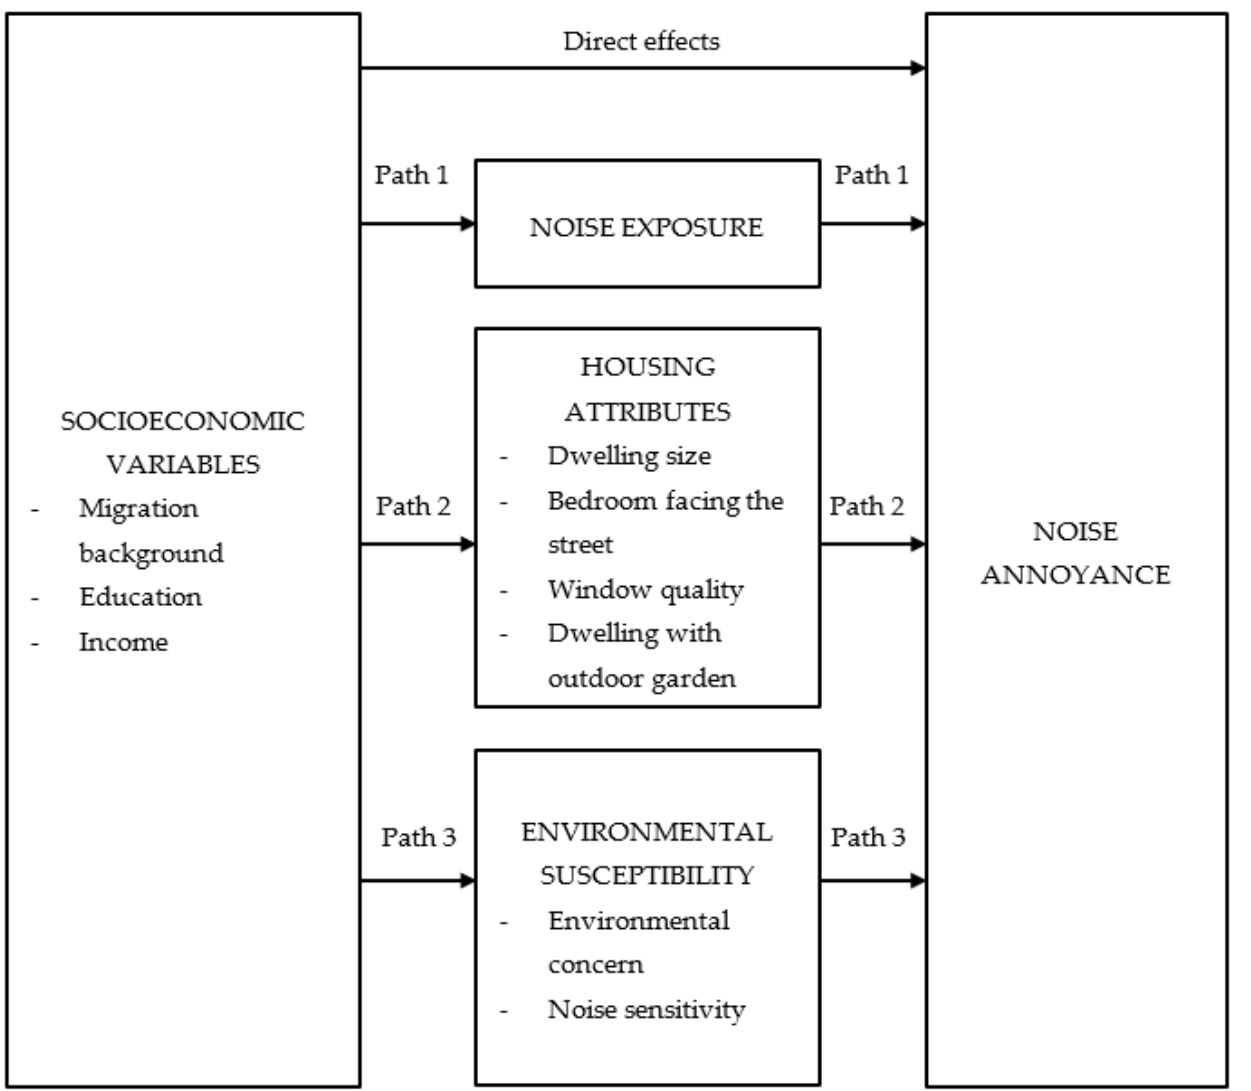
Figure 1. Potential direct and indirect effects of socioeconomic variables on noise annoyance.